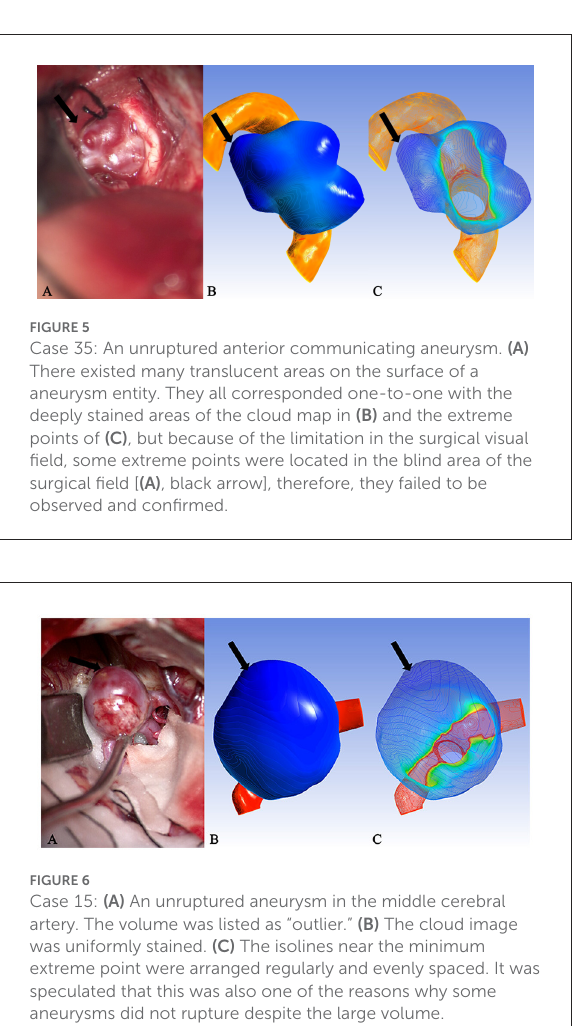
A vs. Groups B + C) (Z = 1.171, P = 0.129). When the